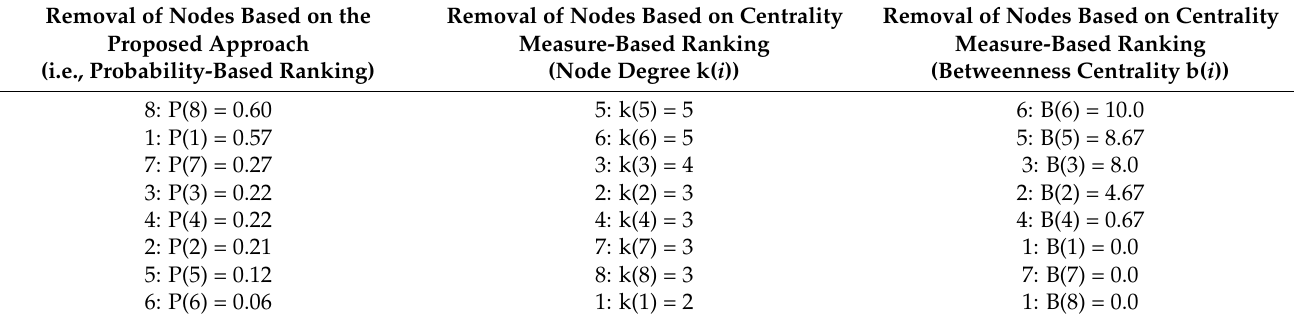
Table 11. Comparison of the results of the proposed approach with other studies in the transportation domain (i.e.,